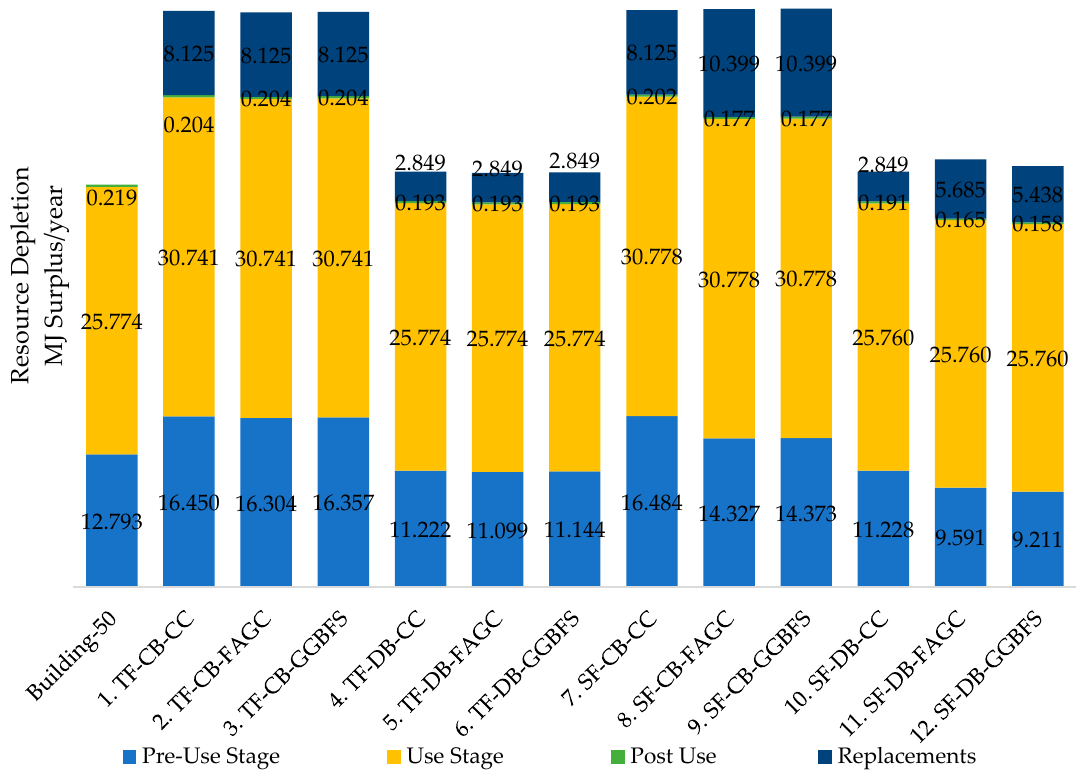
Figure 6. Life cycle resource depletion per year per building for 12 buildings and Building-50.